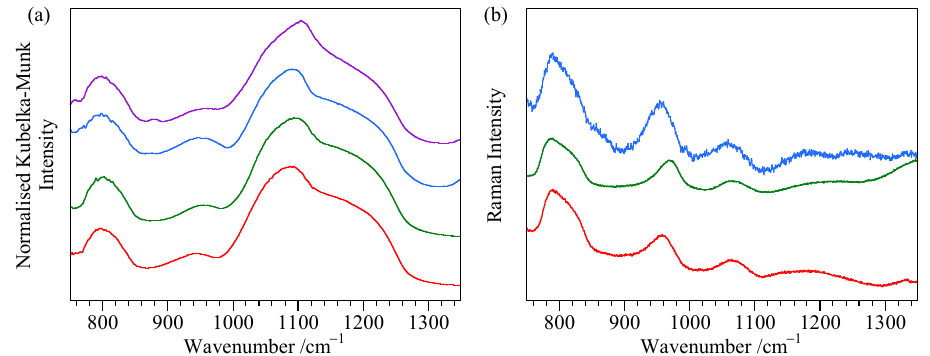
Figure 16. SEM images showing two distinct zones for G34475 (opal-A from Dubnik, Slovakia): ( a ) dull opaque zone and ( b ) white translucent zone.